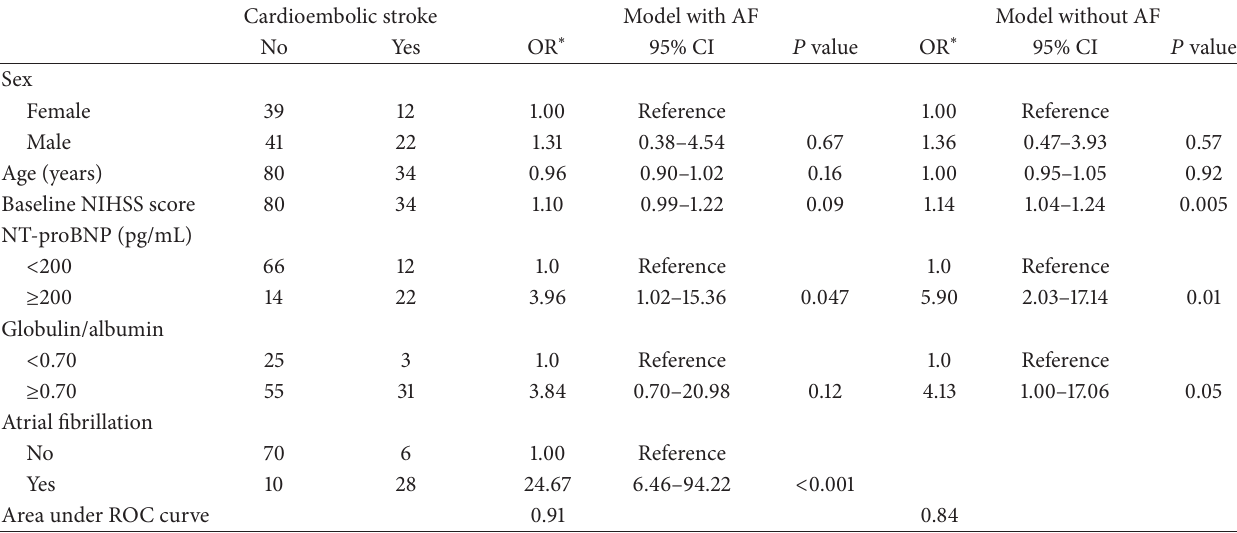
Table 3: Results of multiple logistic regression model for the likelihood of a stroke of cardioembolic origin among 114 patients. Odds ratios (OR) and 95% confidence intervals (95% CI) are estimated from multiple logistic regression models including and excluding atrial fibrillation